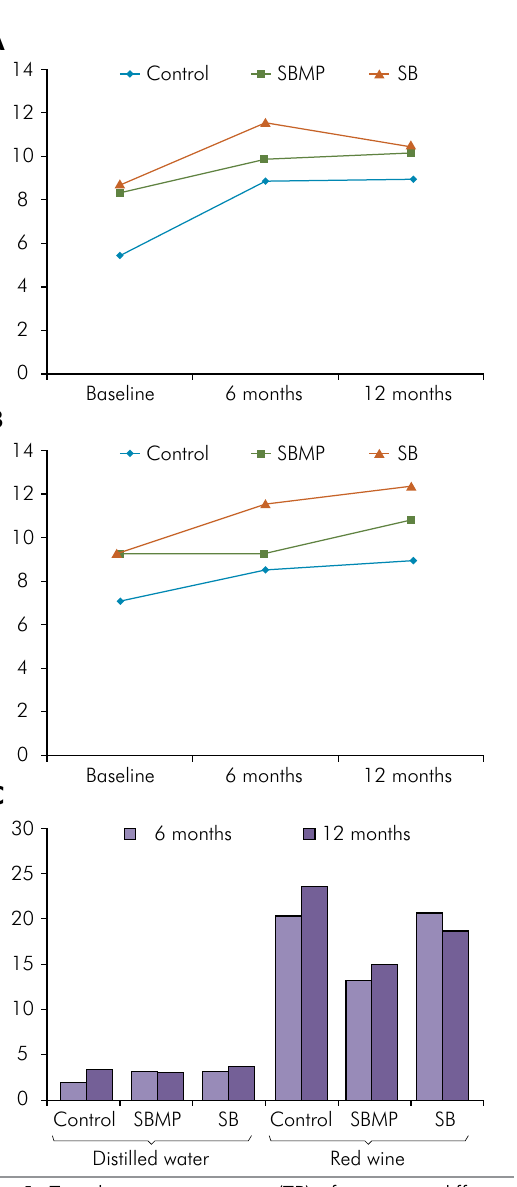
Figure 1. Translucency parameter (TP) of groups at different time points after immersion in distilled water (a) or red wine (b). Color change (ΔE*) of groups after 6 or 12 months of immersion in distilled water or red wine storage